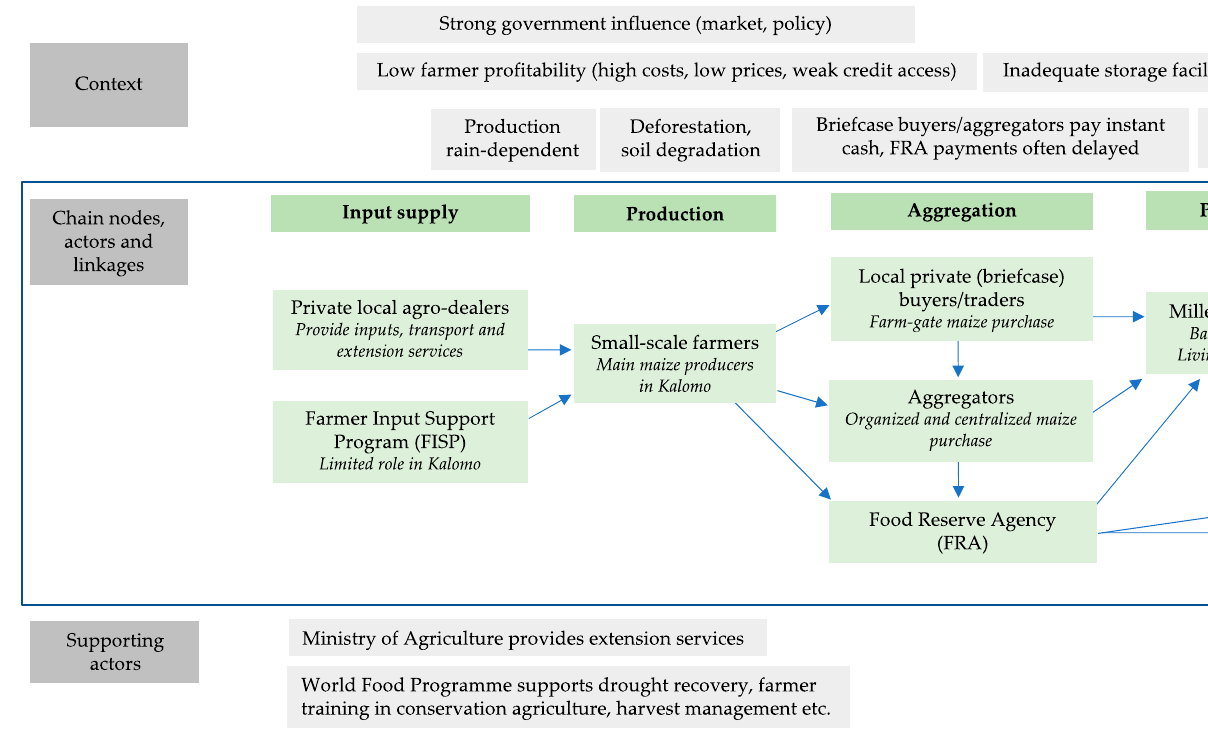
Figure 3. Maize value chain and context in Kalomo District (Source: Authors’ construct based on field research data).